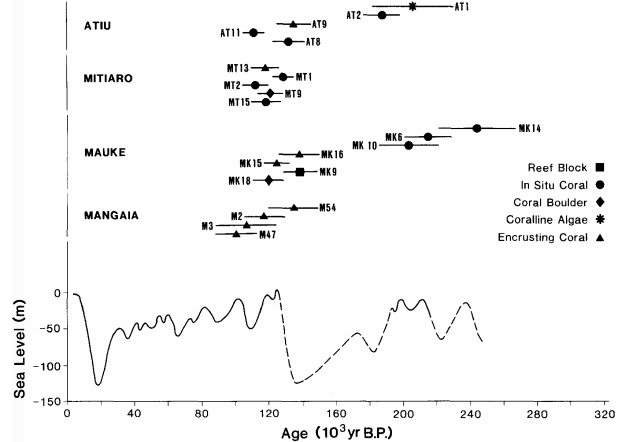
Figure 20. Uranium-series ages ( ± 1 standard error) from corals of the southern Cook Islands, and comparison with the late Quaternary sea-level curve of Chappell and Shackleton (1986) (from Woodroffe et al., 1991).